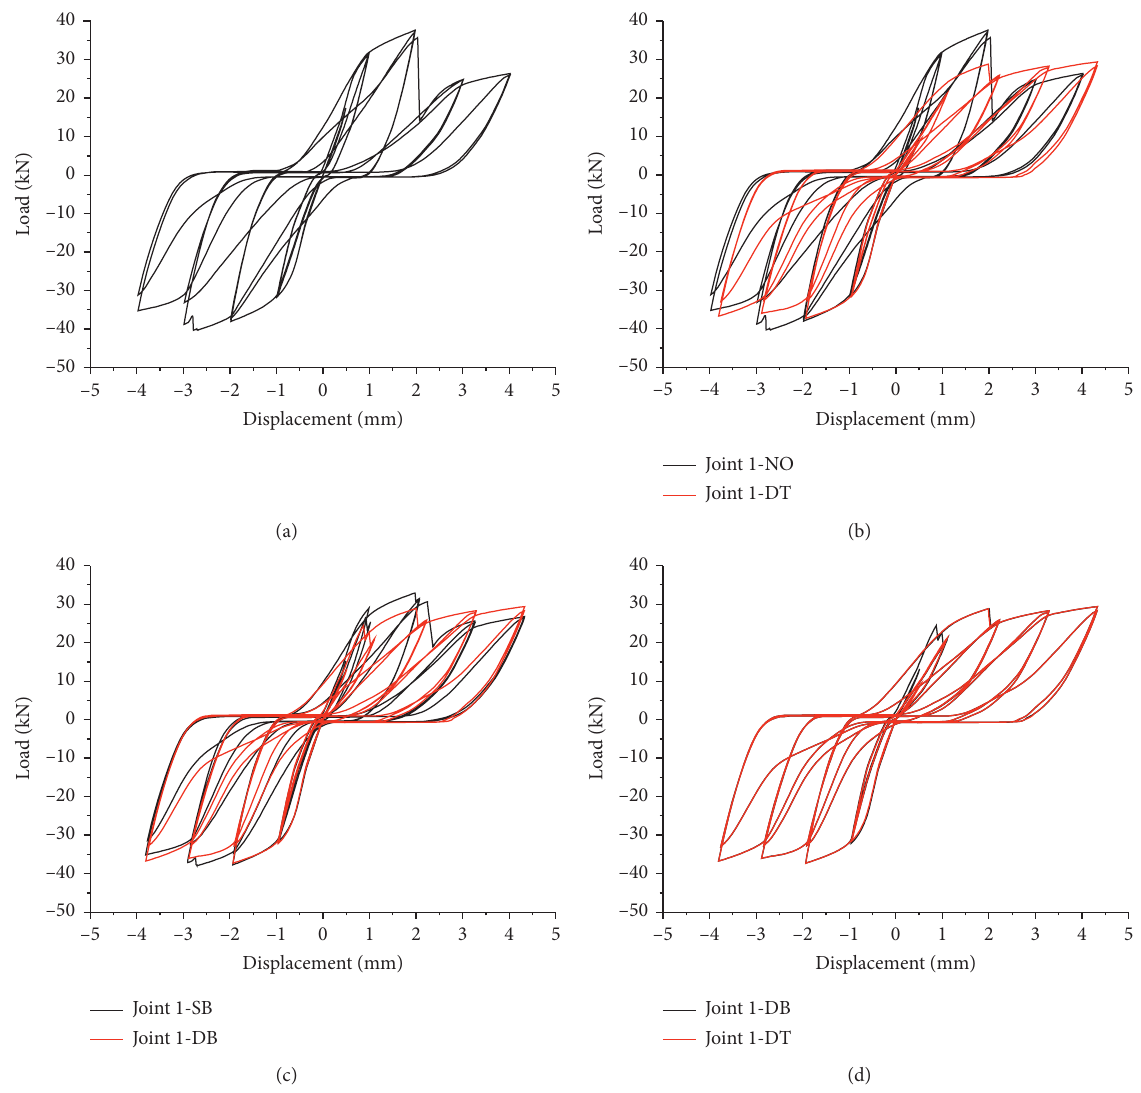
Figure 13: Hysteretic curves of Joint 1: (a) initially perfect Joint 1; (b) comparison between initially perfect Joint 1 and Joint 1-DT; (c) comparison between Joint 1-SB and Joint 1-DB; (d) comparison between Joint 1-DB and Joint